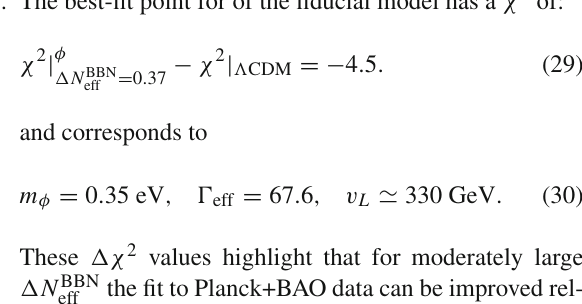
6. The best-fit point for of the fiducial model has a χ 2